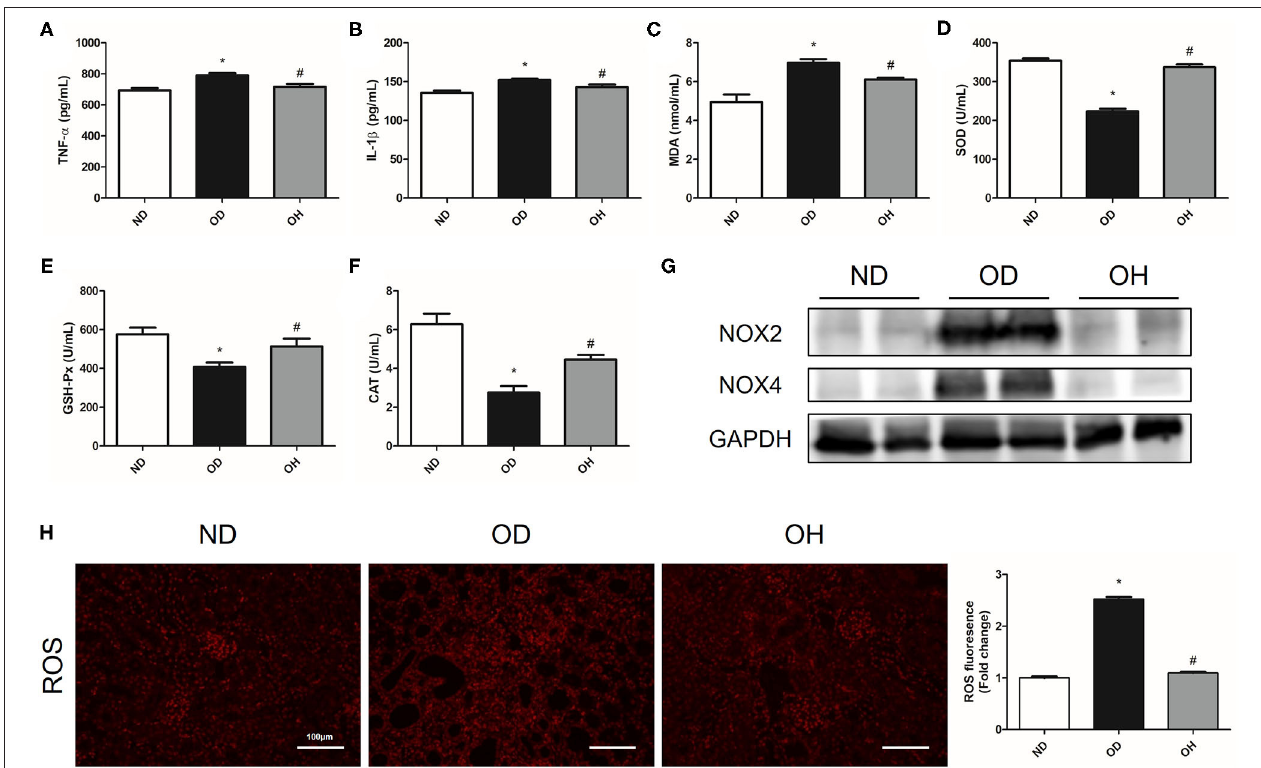
FIGURE 2 | HRW administration improves oxalate-induced inflammation and oxidative stress in mice. (A–F) The levels of TNF- α , IL-1 β , MDA, SOD, GSH-Px and CAT in serum of mice were determined by corresponding kits. (G) The protein expressions of NOX2 and NOX4 in kidneys of mice were detected by western blotting. (H) ROS production in the renal tissues of mice was detected by immunofluorescence (Scale bar = 100 µ m). The results were expressed as mean ± SEM. Statistical comparisons were performed using a NewmanKeuls test (* p < 0.05 vs. ND group, # p < 0.05 vs. OD group).